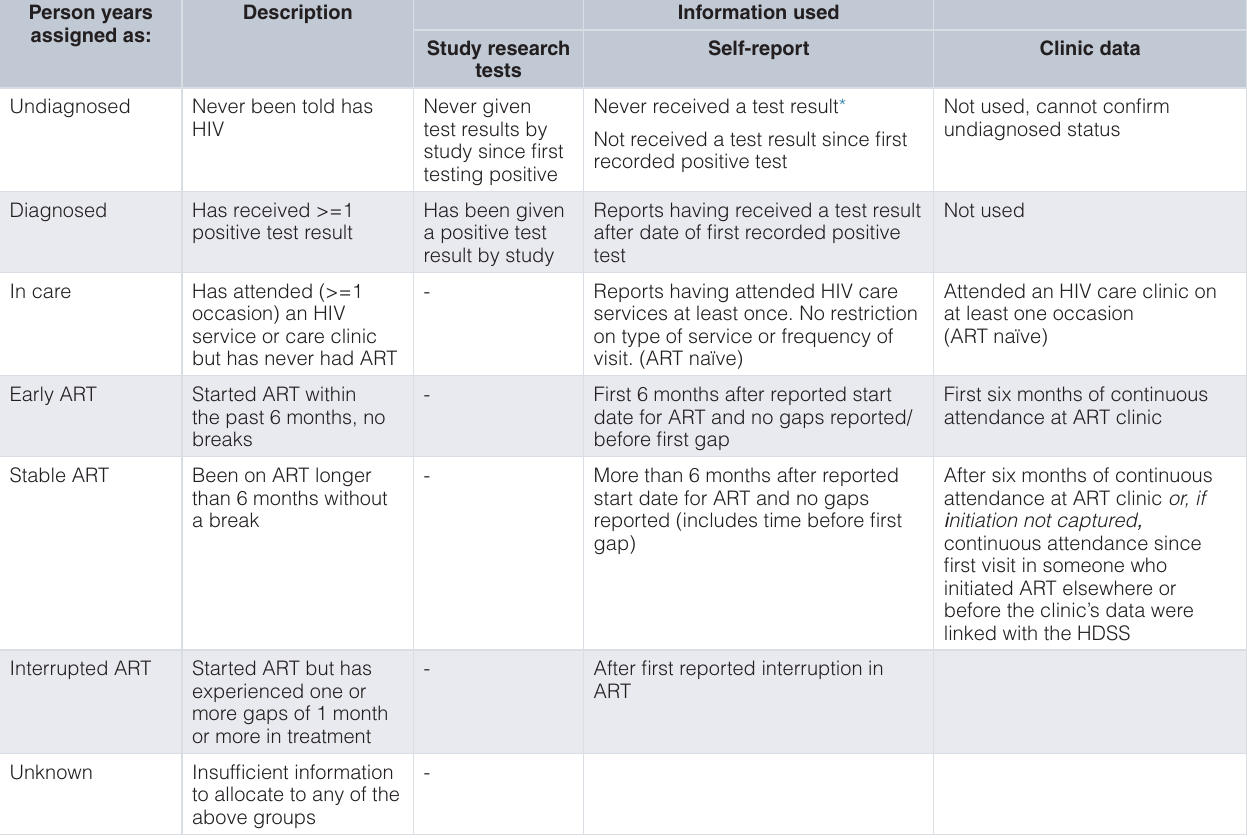
Table 2. Categories on the HIV care and treatment continuum. Person years assigned